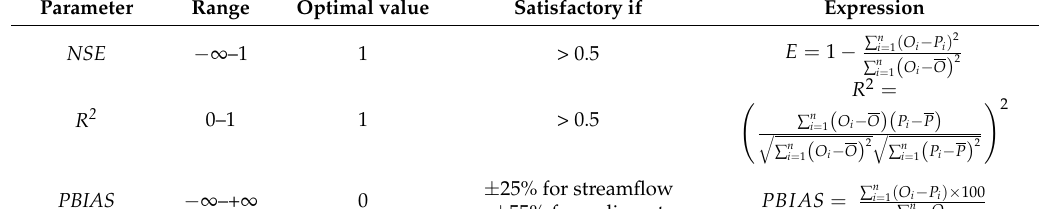
Table 5. Error parameters and accepted ranges for model evaluation [25–27].